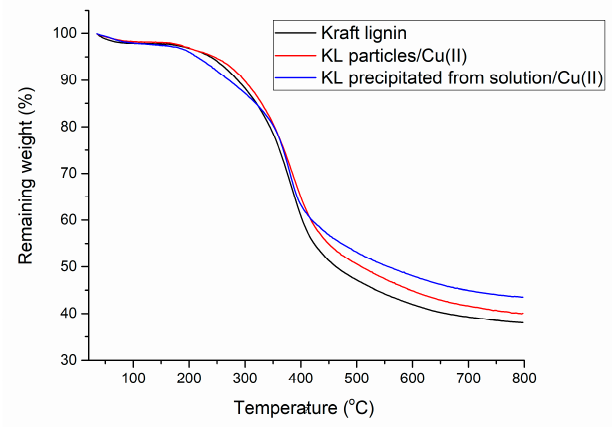
Figure 1. Thermogravimetric analysis for kraft lignin (KL) and the samples with adsorbed copper.